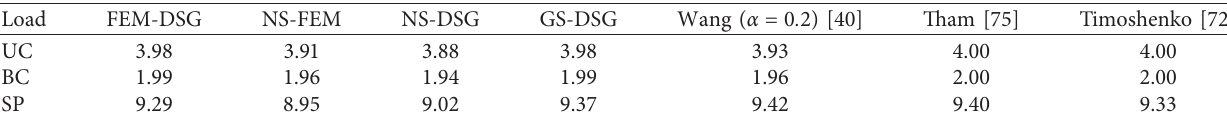
Figure 14: Rectangular plates: (a) model; (b) axial compression; (c) biaxial compression; (d) shear in-plane. Table 9: The buckling load factor K of a simply supported rectangular plate with the length-to-width ratio a / b � 1, thickness-to-width ratio t / b � 0 . 01, and various loading